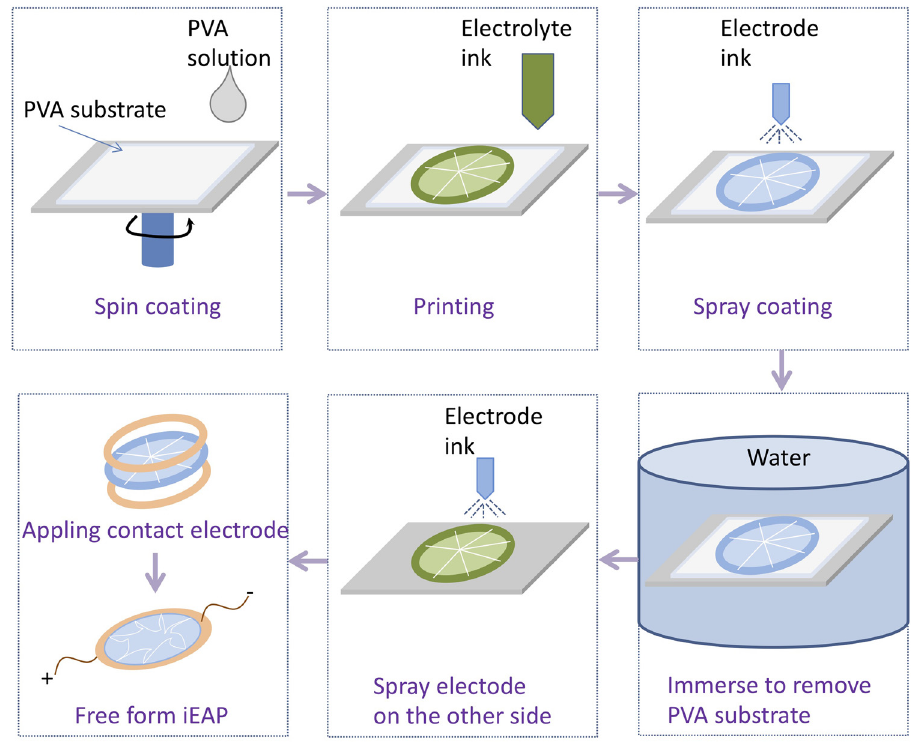
Figure 7: Strategy of fabricating free form